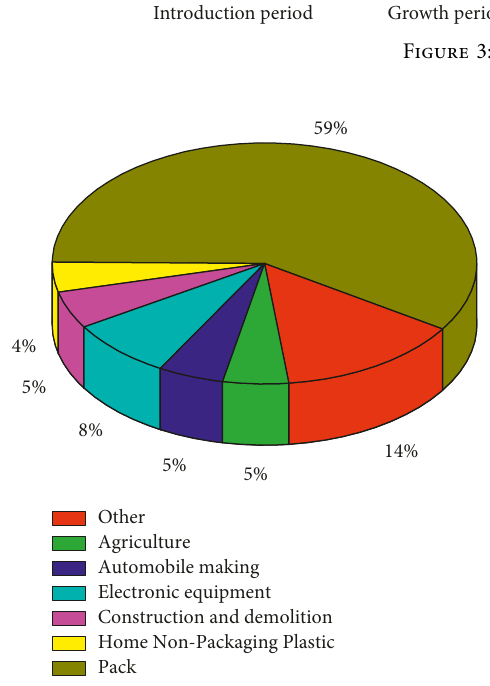
Figure 4: Distribution of global white pollution